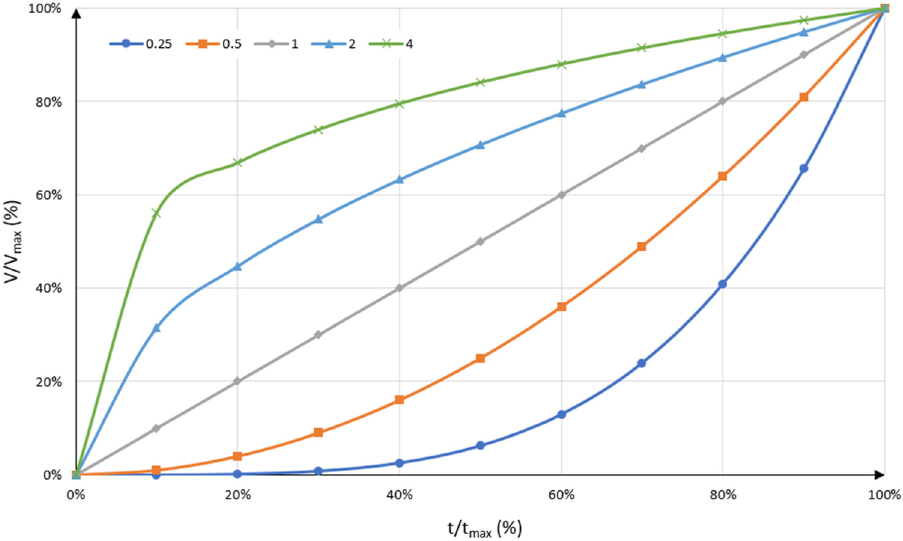
Figure 3. Generic ship speed profiles.